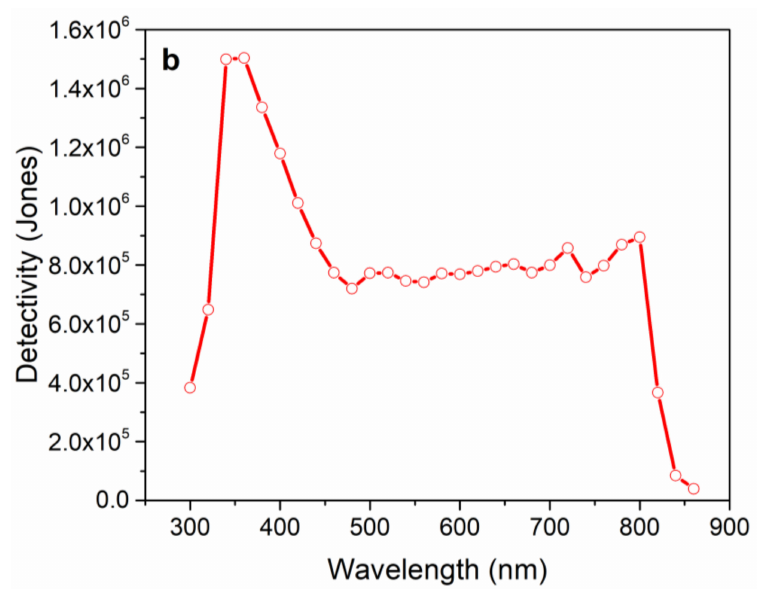
Figure 6. Spectral dependence of responsivity ( a ) and detectivity ( b ) of MSM